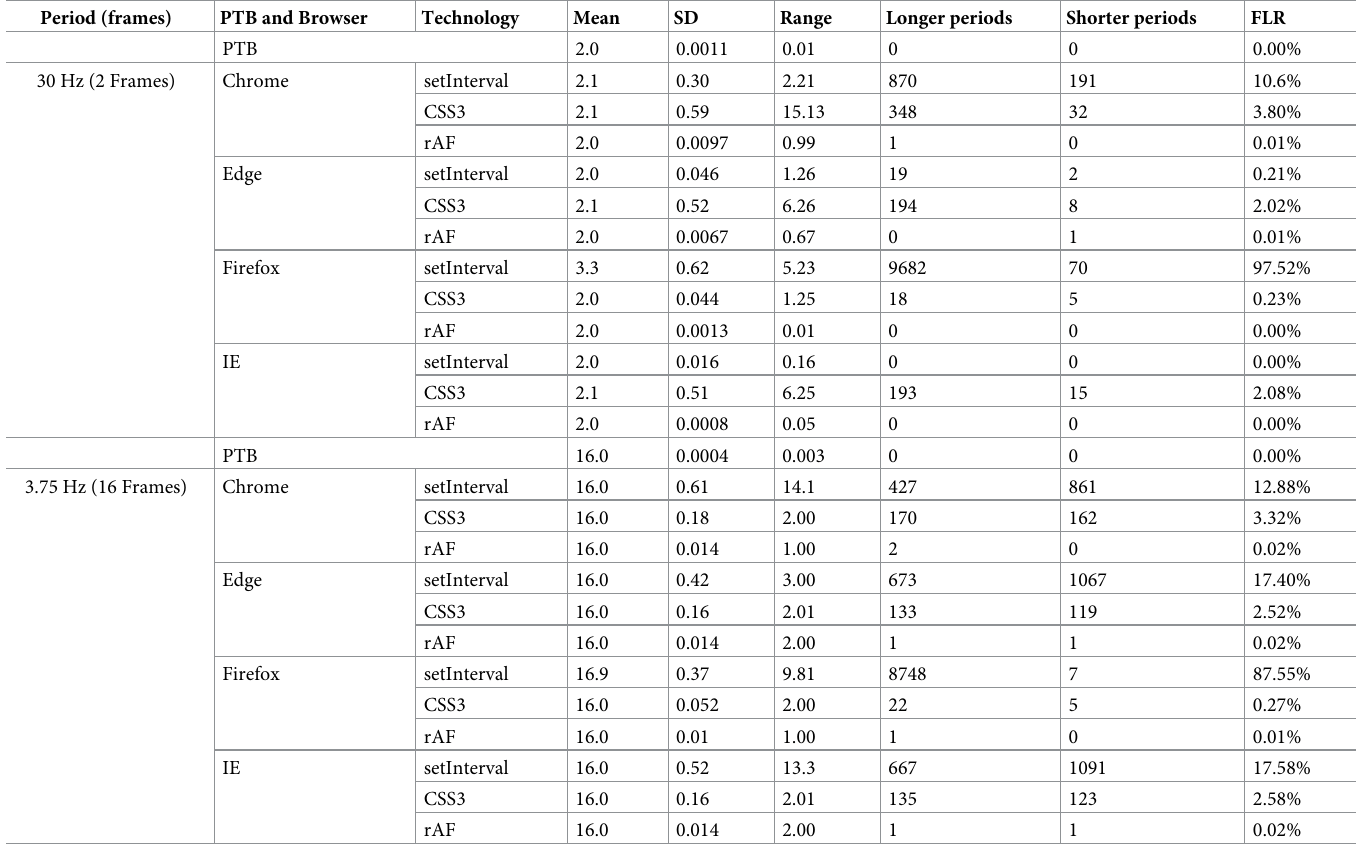
Table 1. The timing accuracies of flashes designed by PTB, setInterval, CSS3, and rAF. The monitor ran at 60 Hz. The temporal frequencies of flashes were 30 Hz (2 frames/period) and 3.75 Hz (16 frames/period). All flashes ran at real-time priority. Period (frames) PTB and Browser 30 Hz (2 Frames)